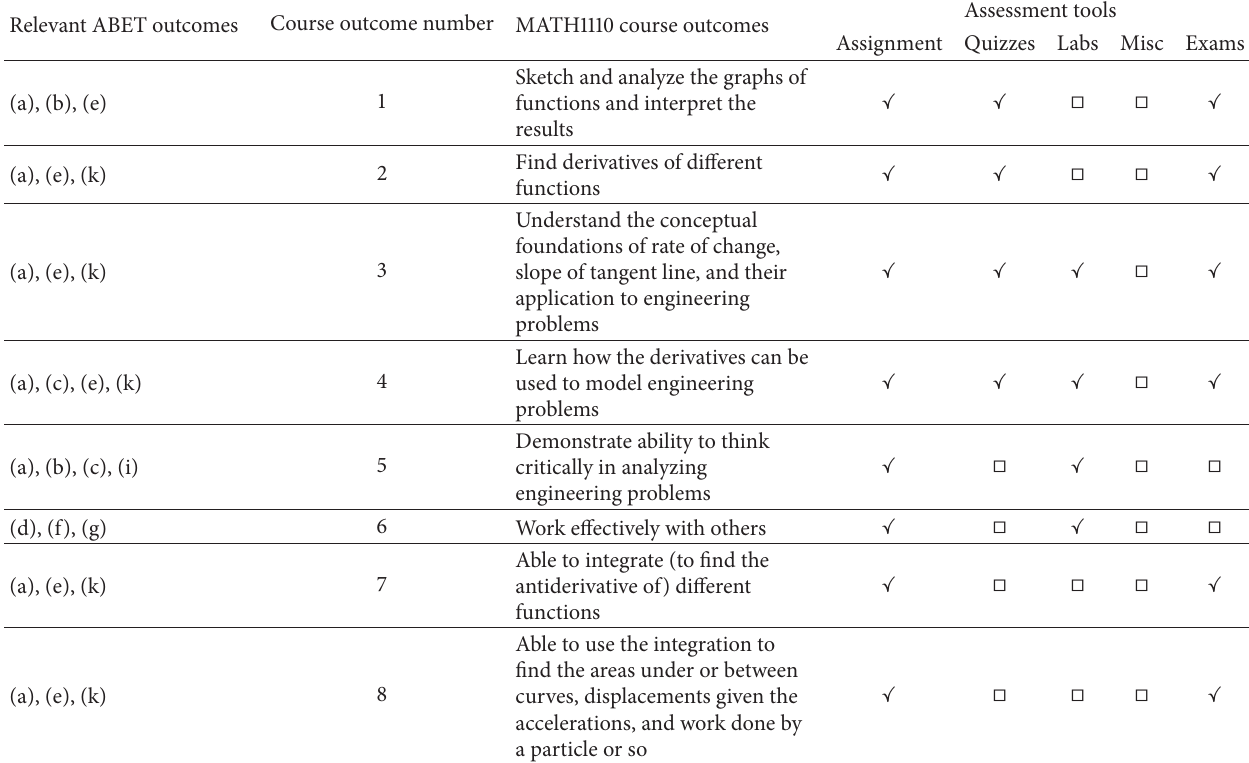
Table 1: Course outcomes, mapping with ABET and students direct assessment tools for the course MATH1110-Calculus I for engineers. Relevant ABET